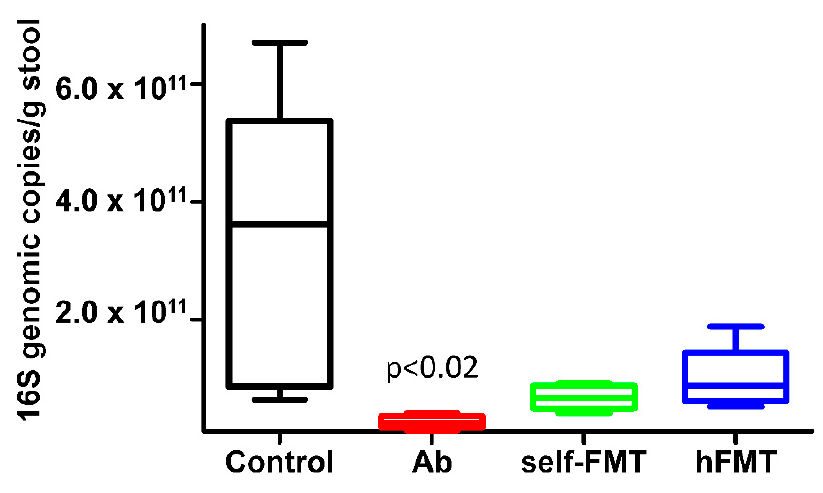
Figure 2. Total bacteria 16S DNA quantification by qPCR. The 16S DNA genomic copies/g of stool are presented for control mice, Ab-treated mice and mice subject to self-FMT and hFMT, respectively. Ab-treated mice had significantly lower amount of genome copies than the other three groups ( p < 0.02). No significant differences were found between the human and self-transplanted groups. The microbiota composition in feces prior to RV challenge was determined by 16S rDNA NGS, showing that bacterial richness and diversity was severely affected after the different treatments (Figure 3A). Chao1 index was lowered in all groups compared to control (microbial richness; p = 2.0365 × 10 − 12 ; F = 206.49, ANOVA) but was higher in self-FMT animals. Diversity (Shannon index) was also lower ( p = 1.8988 × 10 − 8 ; F = 57.299, ANOVA), but was higher in the hFMT group compared to self-FMT group, indicating uneven microbial distribution after treatments. In both types of analyses Ab treatment resulted in lower α diversity. As expected, the three distinct treatments caused